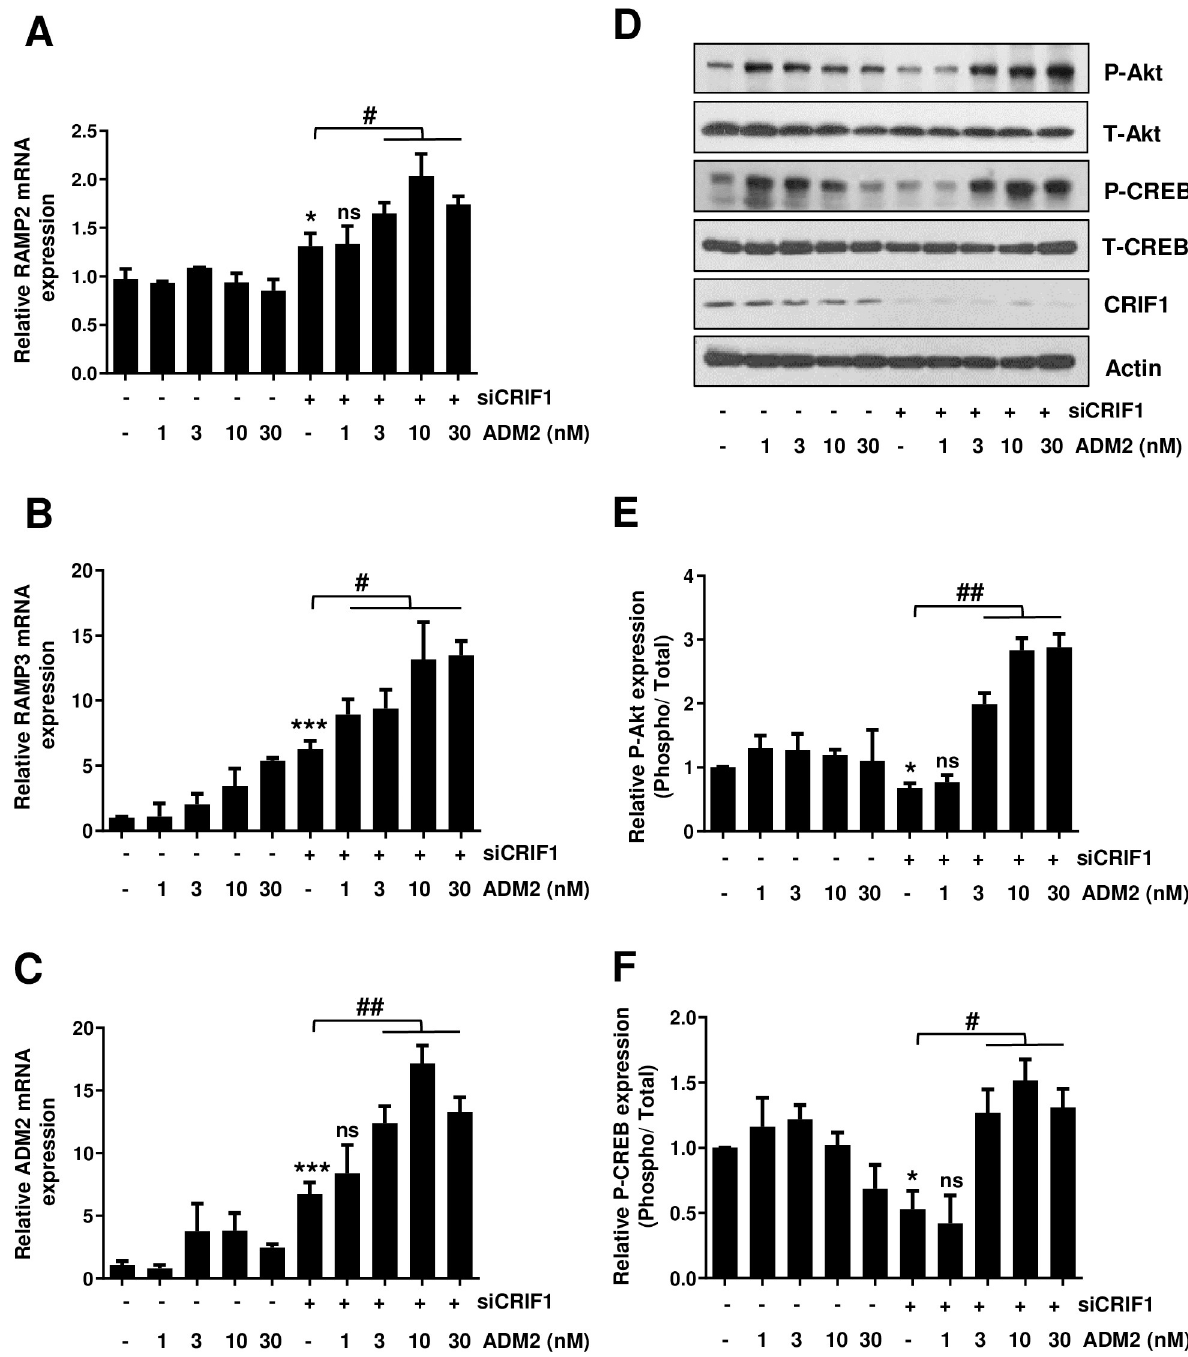
Fig 4. Effect of exogenous ADM2 on the Akt-CREB signaling pathway in CRIF1-silenced endothelial cells. HUVECs were transfected with control or CRIF1 siRNA (100 pmol) followed by treatment with ADM2 for 48 h. Next, the mRNA levels of (A) RAMP2 (B) RAMP3 and (C) ADM2 were determined by qPCR. (D) Western blot analysis of phospho-Akt and phospho-CREB levels. (E and F) Protein levels were quantified by densitometric analysis using ImageJ software. Data are means ± SD of three independent experiments. � P < 0.05 and ��� P < 0.001 relative to the control, # P < 0.05, ## P < 0.01 and ns = not significant relative to siCRIF1 (n = 3 per group).